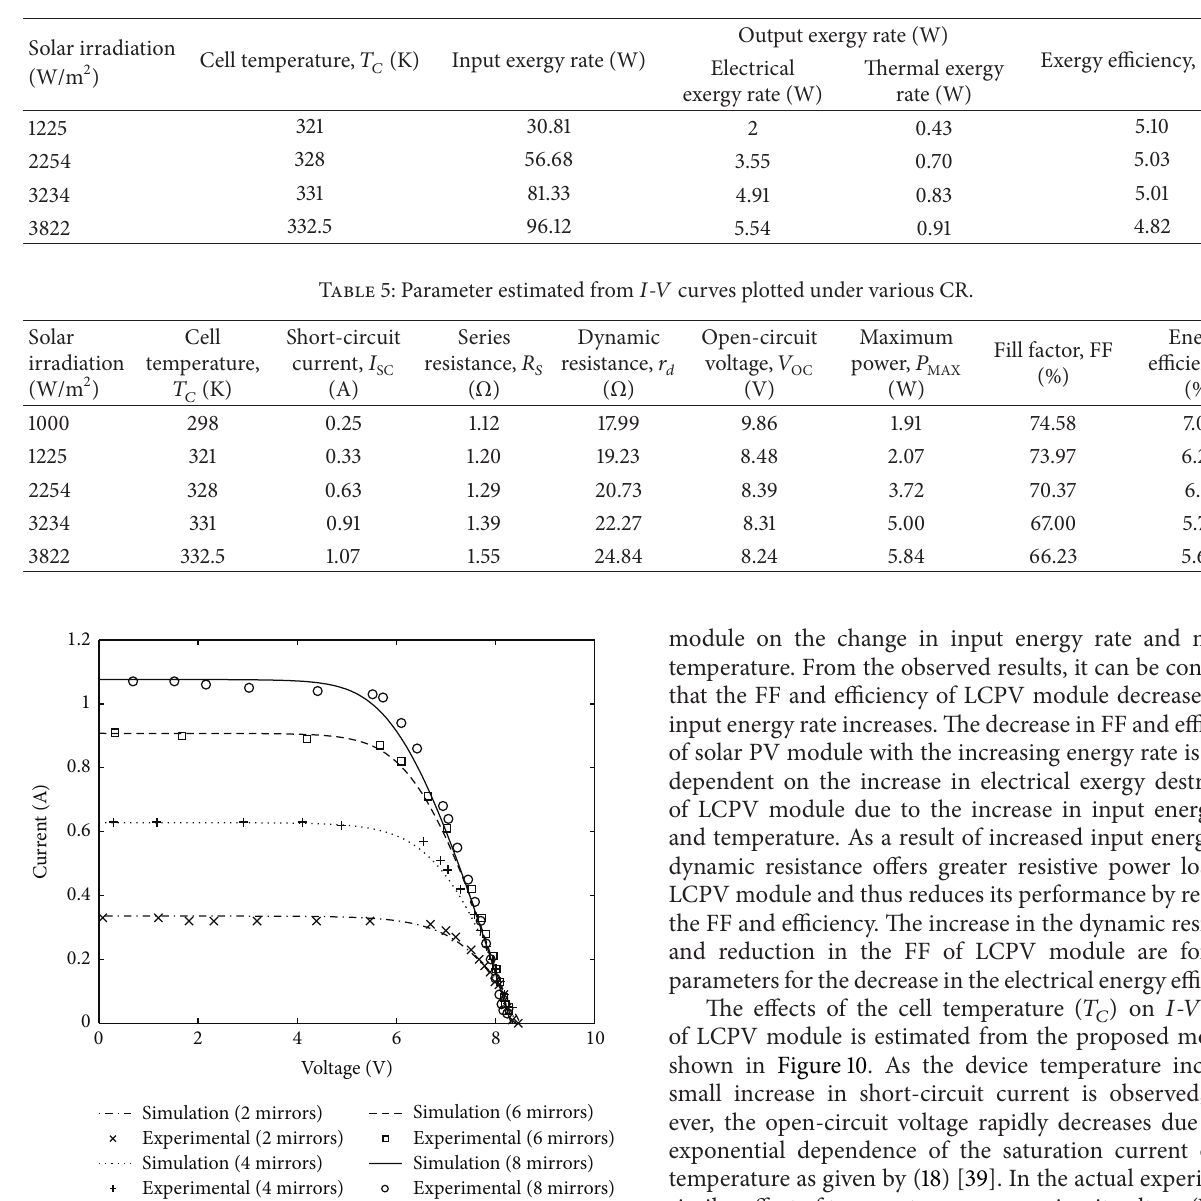
Table 4: Exergy analysis of LCPV system.